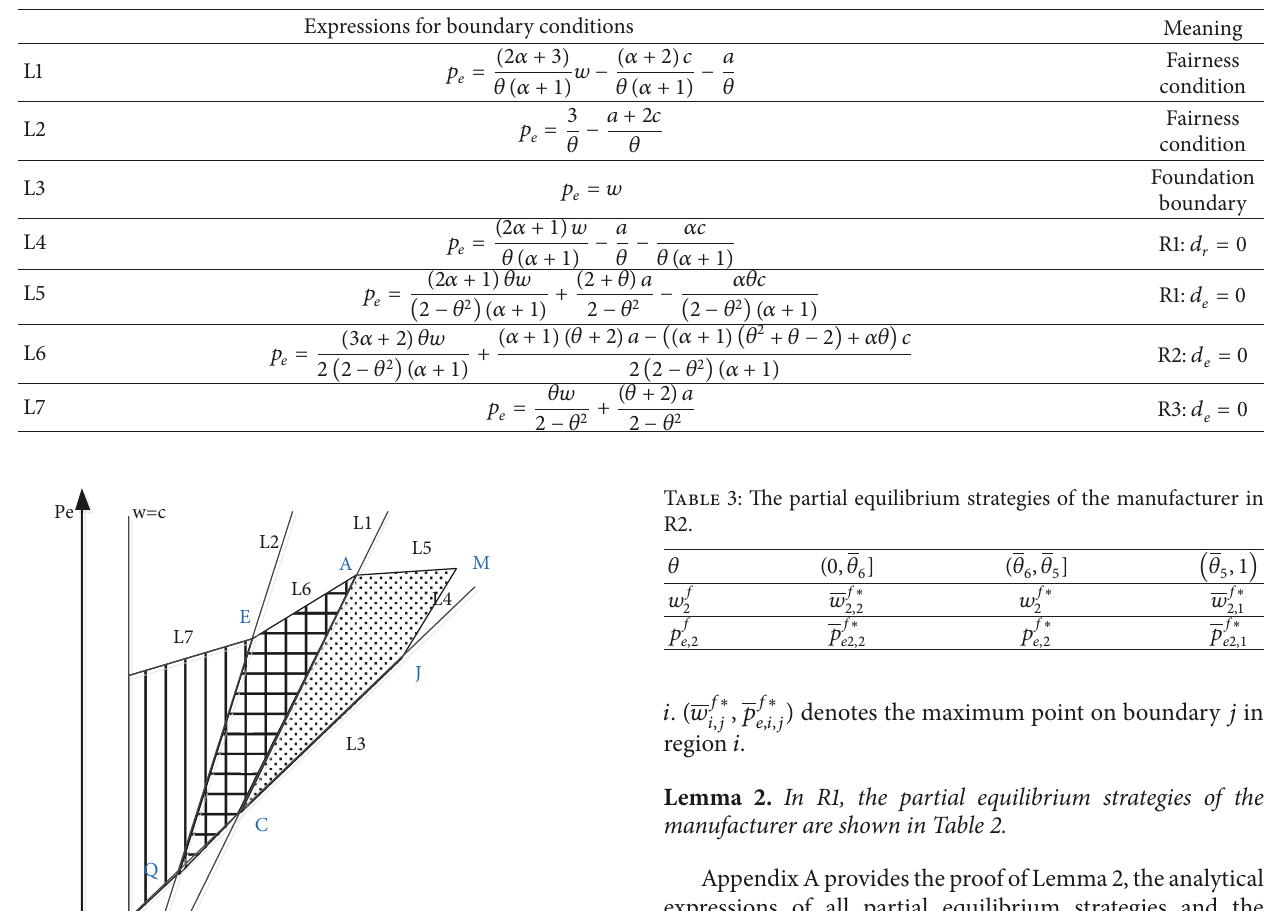
Table 1: Boundary conditions of the feasible region.